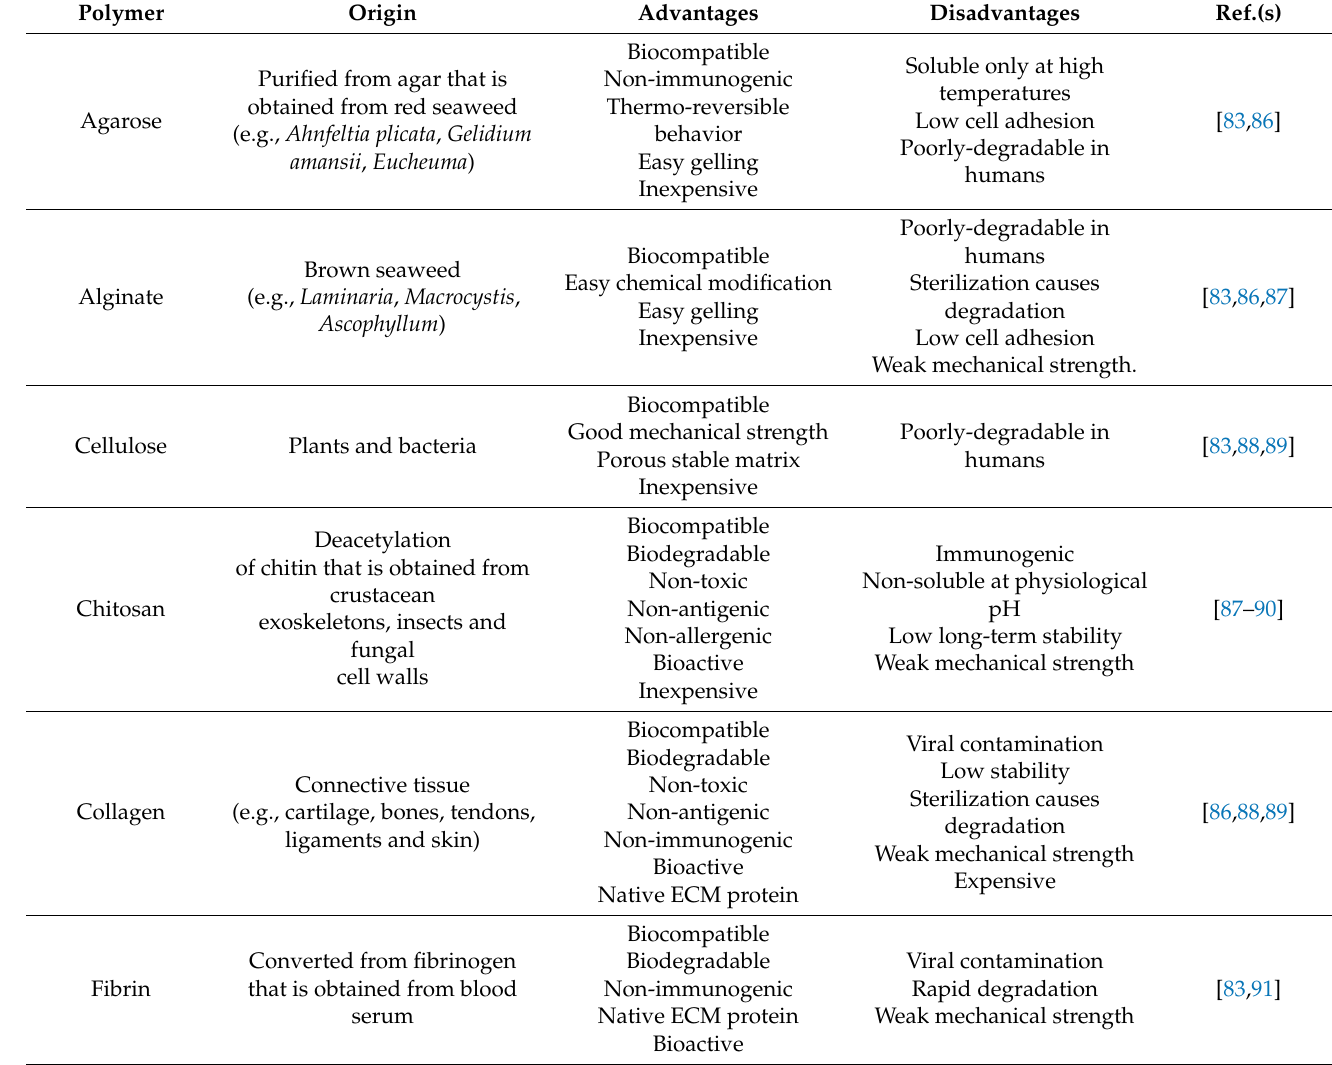
Table 5. Naturally occurring polymers: origin and major advantages/disadvantages for biomedical and pharmaceutical